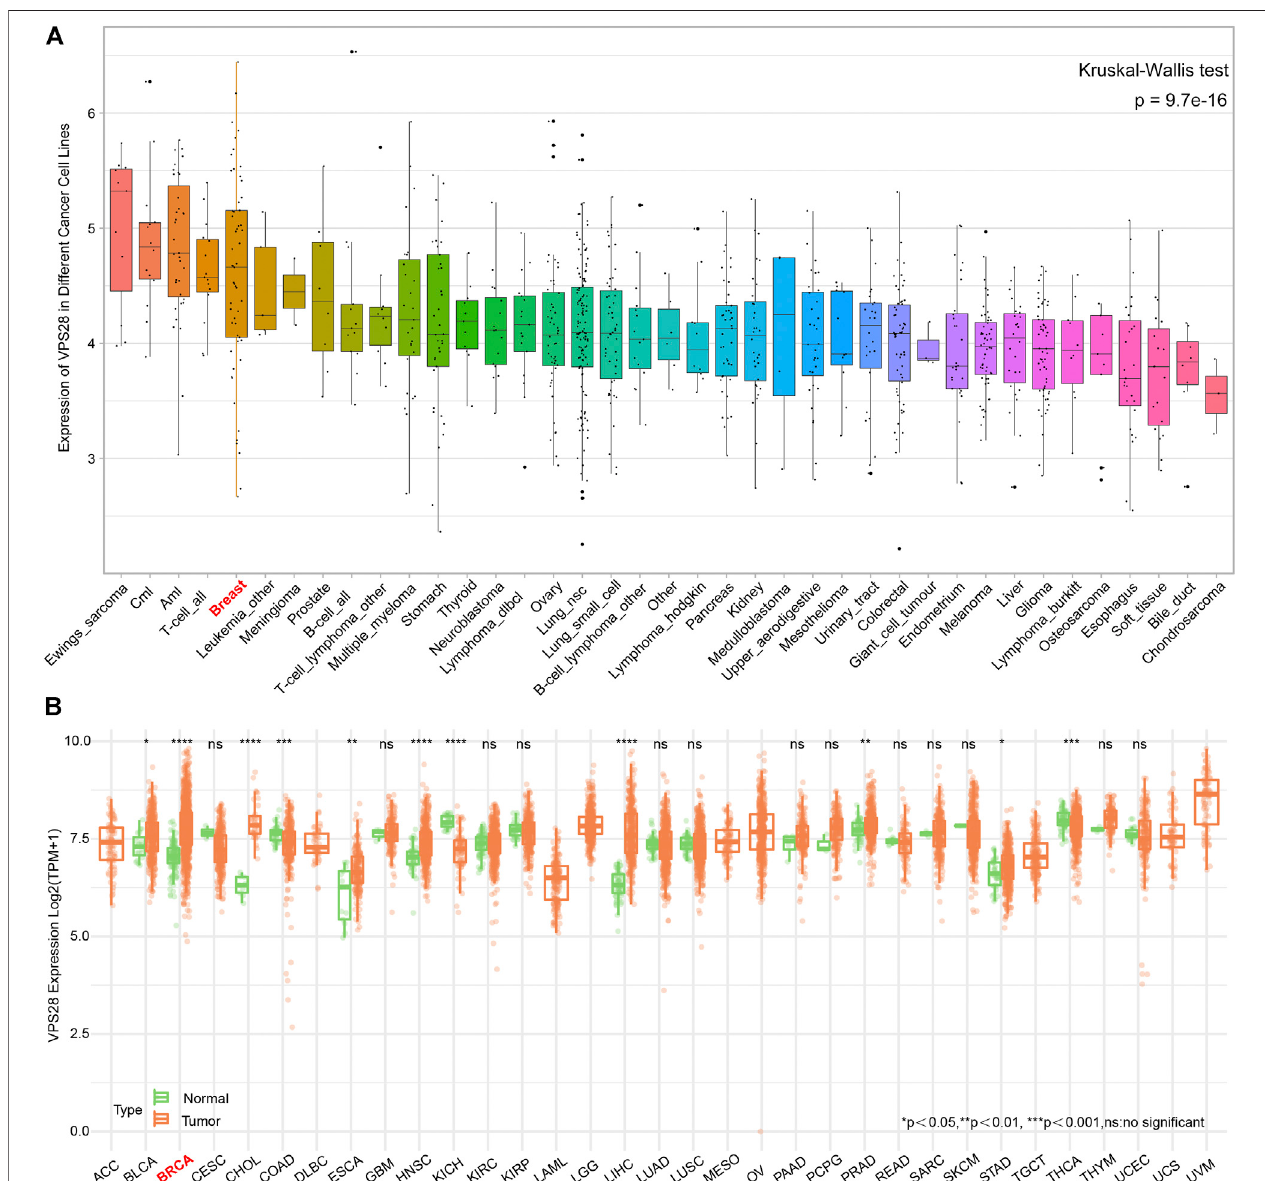
FIGURE1| ThemRNAexpressionofVPS28inpan-cancercelllinesandtissues.ThemRNAexpressionpatternofVPS28inpan-cancercelllinesaccordingtodata collected from the CCLE database (A) and in pan-cancer tissues from the TCGA database (B) .